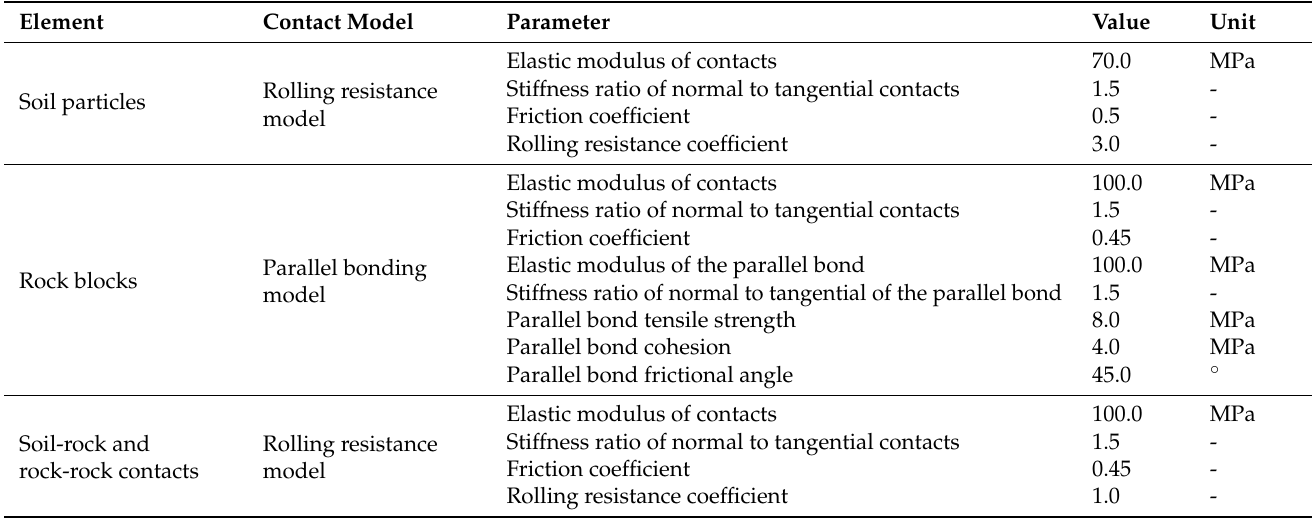
Figure 2. The calibration models for ( a ) soil, ( b ) rocky block and ( c ) mixture samples (after [31]). Table 1. The calibrated micro parameters for DEM simulations.